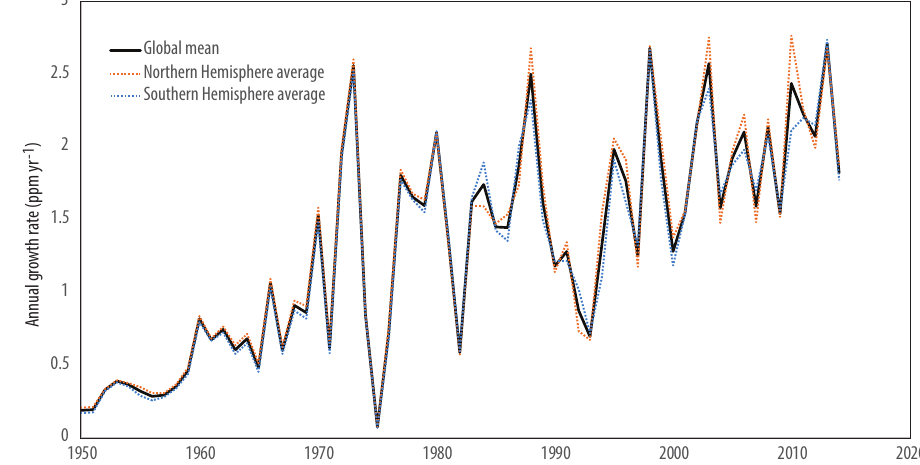
Figure 10. Annual growth rate of CO 2 concentrations for global-mean, northern hemispheric average and southern hemispheric average concentrations. Before 1960, the smooth growth rate results from interpolated global mean values. After 1960, the growth rates are diagnosed from the surface station data, as shown in Fig. 9f. Noticeable are fluctuations of the annual growth rate around 1973, 1981 and